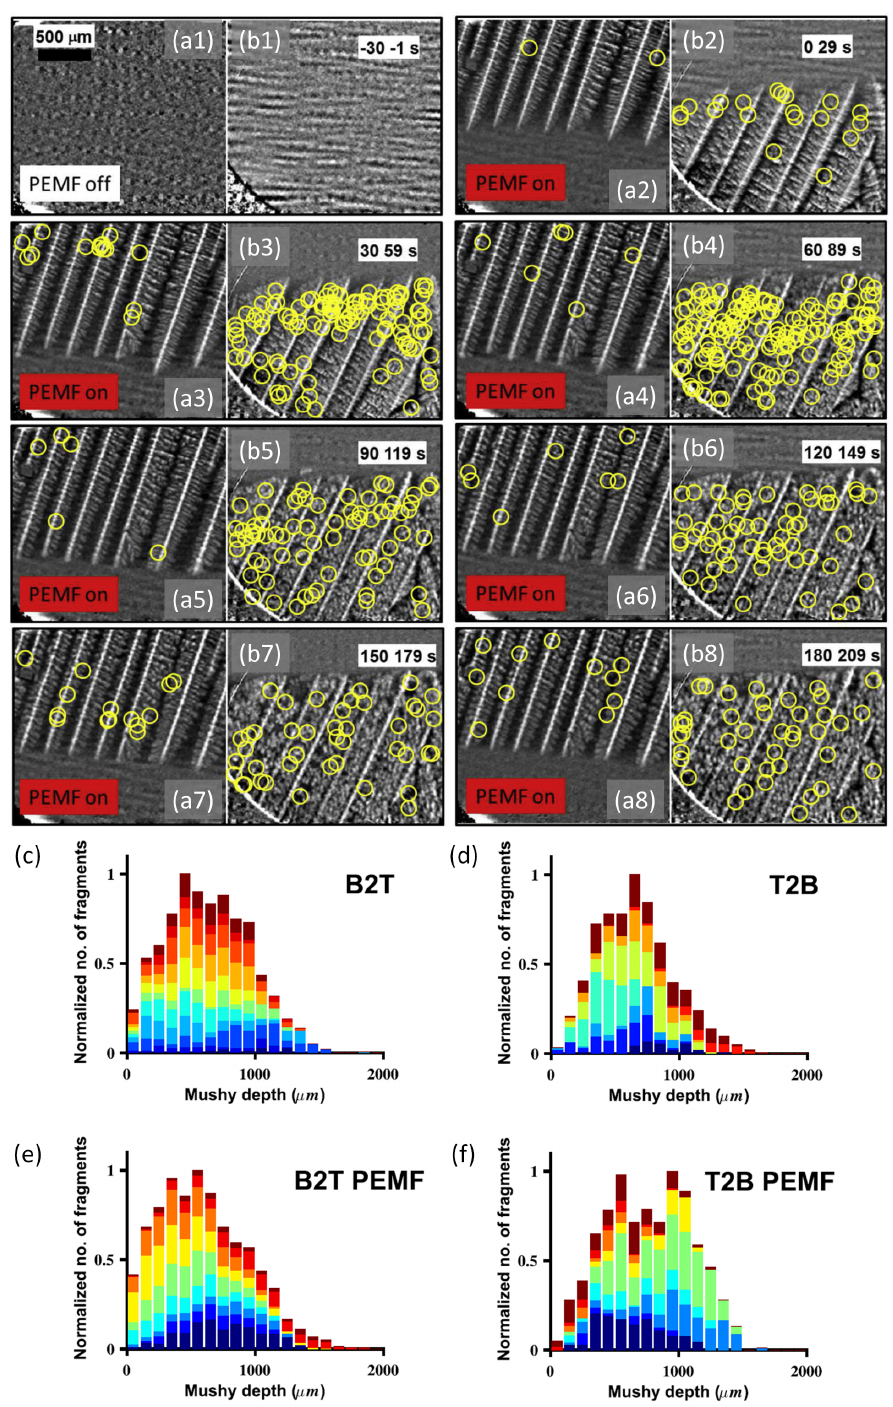
Figure 4. ( a1 – a8 , b1 – b8 ) Two radiograph sequences side-by-side showing dendrite fragmentation for top-to-bottom (T2B, left paired image) and bottom-to-top (B2T, right paired image) solidification of an Al-15wt.%Cu alloy at a thermal gradient of G = ± 48Kmm − 1 and under an external PEMF ( F = ± 0.3mN). ( c – f ) Normalised total number of fragments as a function of distance into the mushy zone, measured from the tip of the longest dendrite, for four different experimental conditions in Al-15wt.%Cu. The bar colours correspond to the relative contribution of an individual experiment to the overall distribution [23] (Reprinted with permission from [23]. Copyright 2016